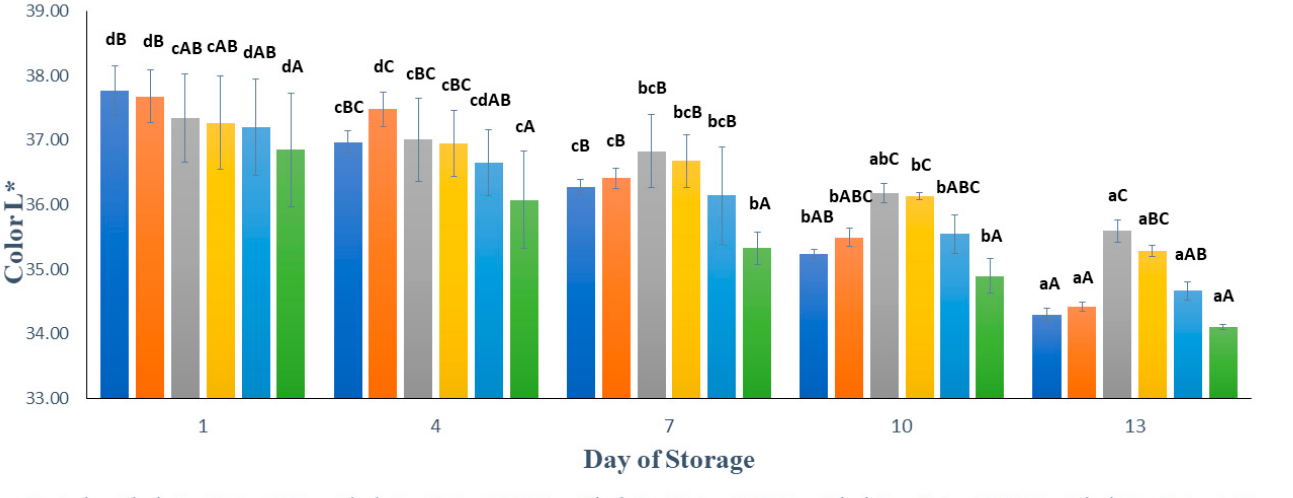
Figure 4. Effect of edible coating of gelatin composite enriched with black tea extract on the color (L*) of minimally processed watermelon during storage. The value shown is the average of the three experimental replications. A–C Values followed by the same capital letters showed no significant difference ( p > 0.05) between treatments on the same day. a–d Values followed by the same non-capital letters showed no significant difference ( p > 0.05) between storage times in the same treatment.